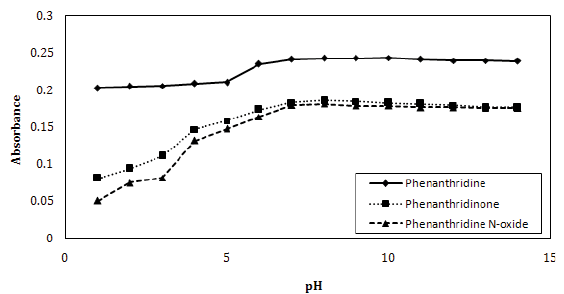
Figure 2. Variation of absorbance of 5 µmol L -1 phenanthridine, phenanthridinone and phenanthridine N-oxide measured at 248, 236 and 237 nm, respectively, versus